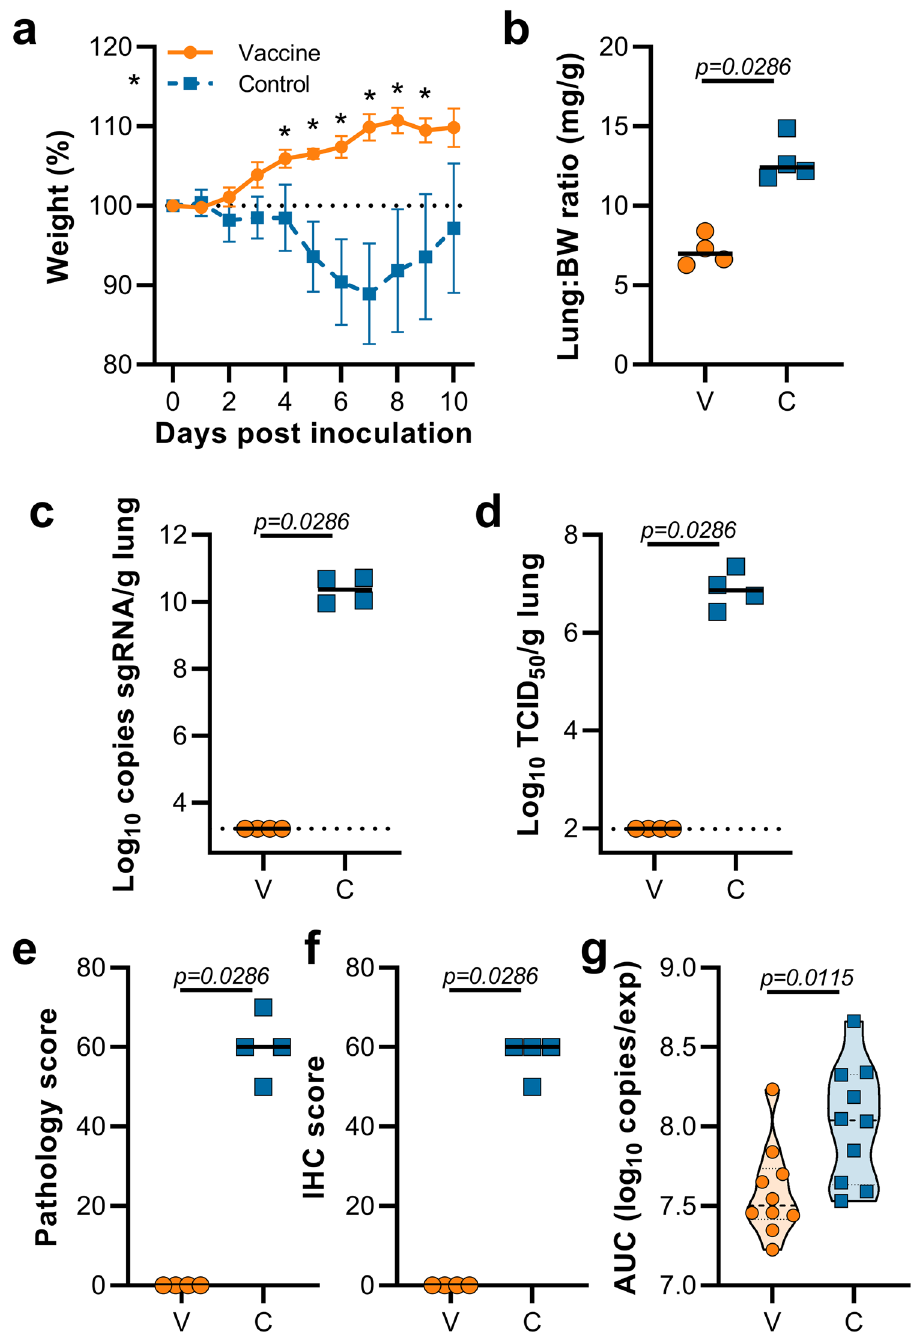
Fig. 2 Vaccination of Syrian hamsters with ChAdOx1 nCoV-19 prevents lower respiratory tract infection with SARS-CoV-2 VOC B.1.1.7. a Relative weight upon intranasal challenge with 10 4 TCID 50 of B.1.1.7. Shown is the geometric mean with a 95% con fi dence interval (CI). * p -value < 0.05, corrected for multiple comparisons using the Holm – Š idák correction. b Lung:body weight (BW) ratio (mg:g) of hamsters euthanized at 5 DPI. Line = median. c sgRNA viral load in lung tissue obtained at 5 DPI. Line = median. Dotted line = limit of detection. d Infectious SARS-CoV-2 titer in lung tissue obtained at 5 DPI. Line = median. Dotted line = limit of detection. e Percentage affected lung tissue per animal as determined via histology. Line = median. f Percentage of lung tissue positive for SARS-CoV-2 antigen per animal. Line = median. g Truncated violin plot of the area under the curve (AUC) analysis of shedding as measured by sgRNA analysis in swabs collected on 1 – 5 DPI. Dashed line = median. Dotted line = quartiles. Statistical signi fi cance determined via multiple student t -tests with an n of 10 biologically independent animals ( a ), or two-tailed Mann – Whitney test ( b – e ) with an n of 4 biologically independent animals and ( g ) with an n of 10 biologically independent animals. p -values for days 4, 5, 6, 7, 8, 9, and 10 are 0.001251, < 0.000001, < 0.000001, < 0.000001, < 0.000001, < 0.000001, and < 0.000001, respectively. V = ChAdOx1 nCoV-19 vaccinated; C = ChAdOx1 GFP vaccinated; Orange circle = Hamsters vaccinated with ChAdOx1 nCoV-19, Blue square = Hamsters vaccinated with ChAdOx1 GFP.